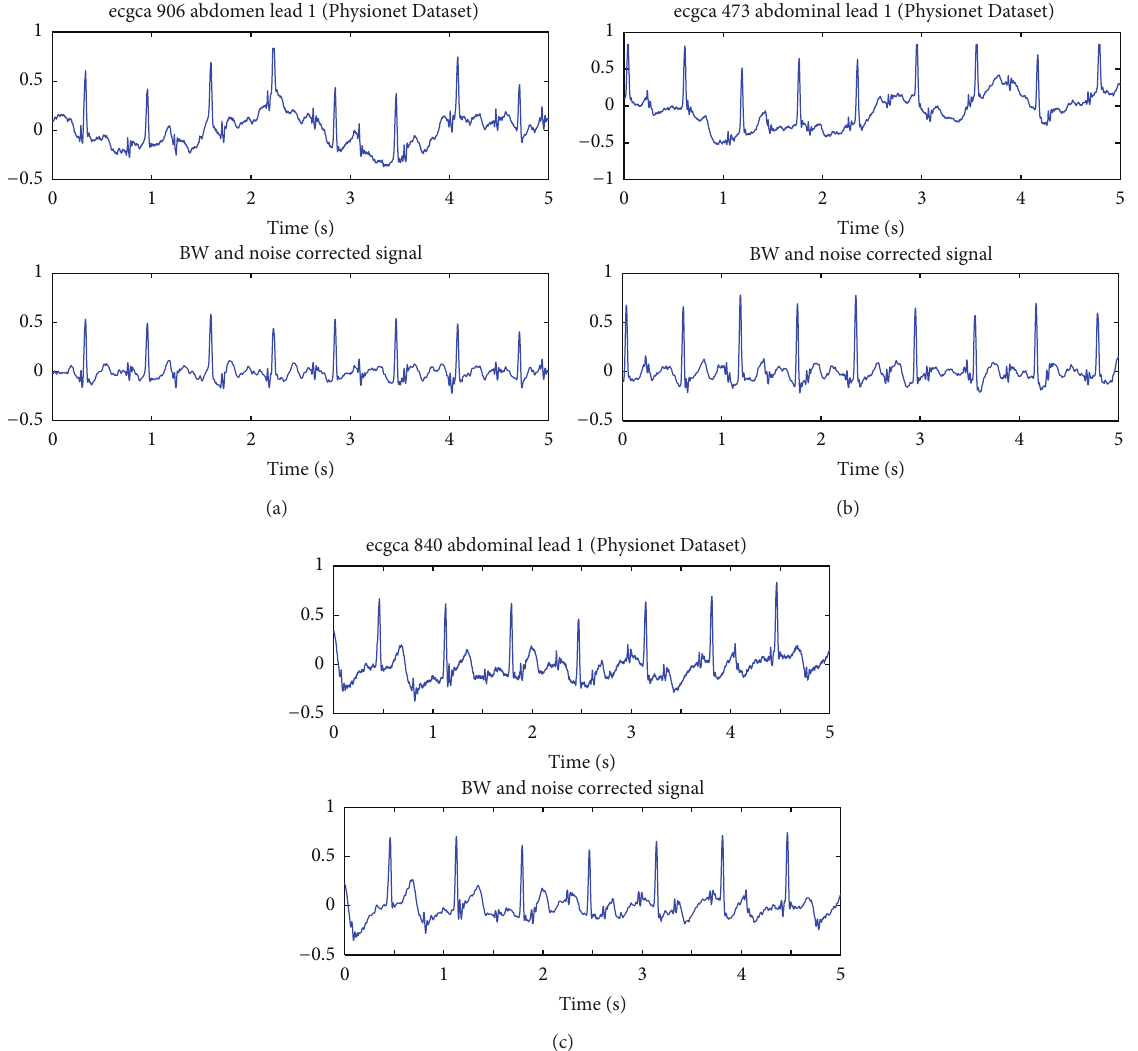
Figure 8: Noninvasive Fetal ECG Database (Physionet Dataset): (a) ecgca 906 lead 1 signal, BW and noise corrected signal; (b) ecgca 473 lead 1 signal, BW and noise corrected signal; (c) ecgca 840 lead 1 signal, BW and noise corrected